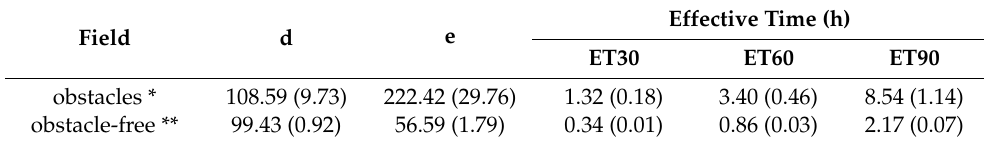
Table 3. Parameters of the non–linear asymptotic regressions (Equation (3)) and effective times of the autonomous mower estimated from the two-stage meta-analysis dose–response model for an area of 112 m 2 with obstacles and